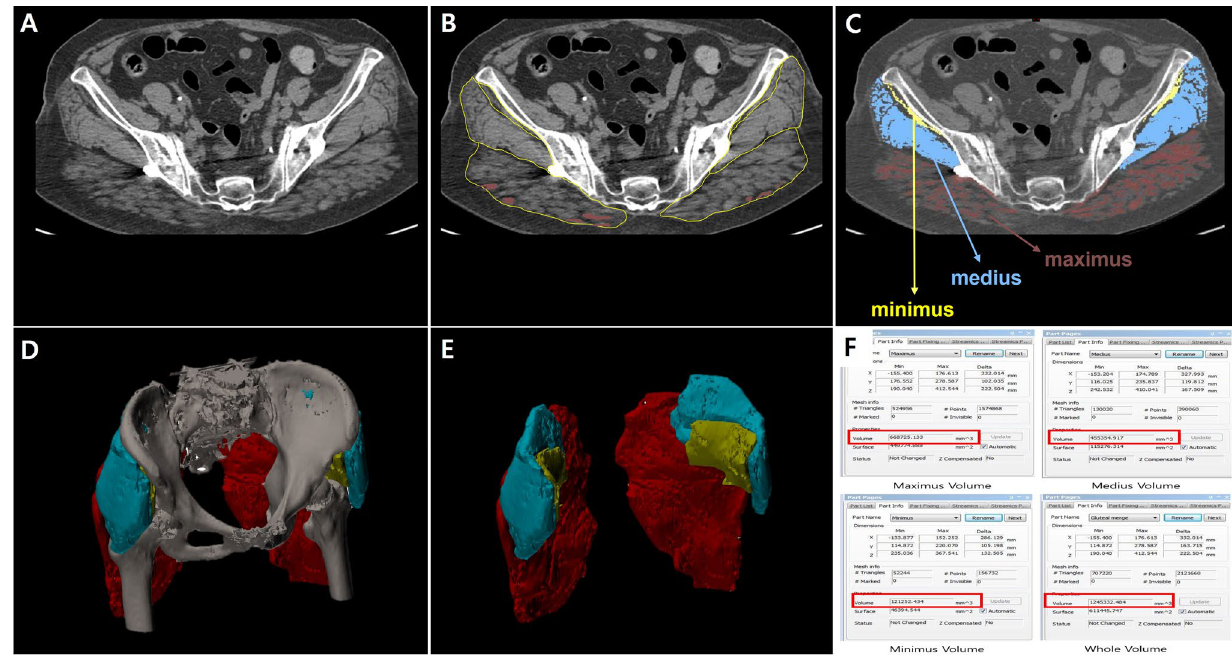
Figure 2. Gluteal muscle volume measurement; ( A ) A series of cross-sectional images of lumbosacral 3-dimentional CT. ( B and C ) After uploading to the computer aided design program, outlining and masking the gluteus maximus, medius, and minimus muscles. ( D and E ) After removing the fat tissue, abdominal organs and bony structures, obtaining the pure muscle mass. ( F ) Calculating the sum of the cross-sectional area of each muscle and estimating the volume of each